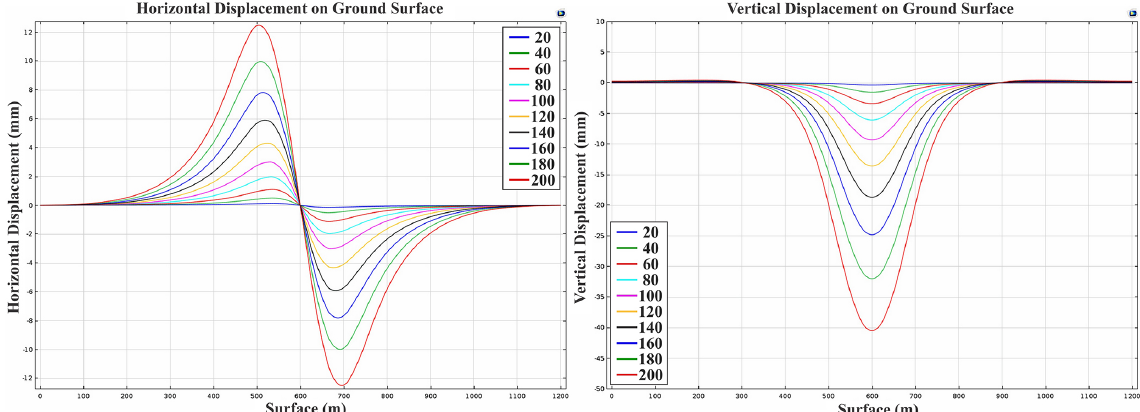
Figure 7. Horizontal and Vertical displacement of surface induced by a shallow seated cavity.